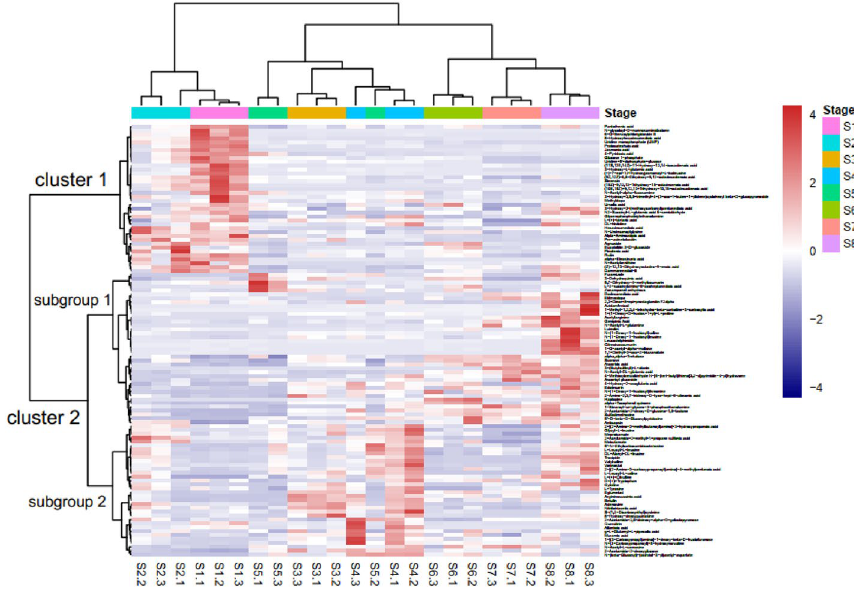
Figure 3. Heatmap of the 111 putatively annotated